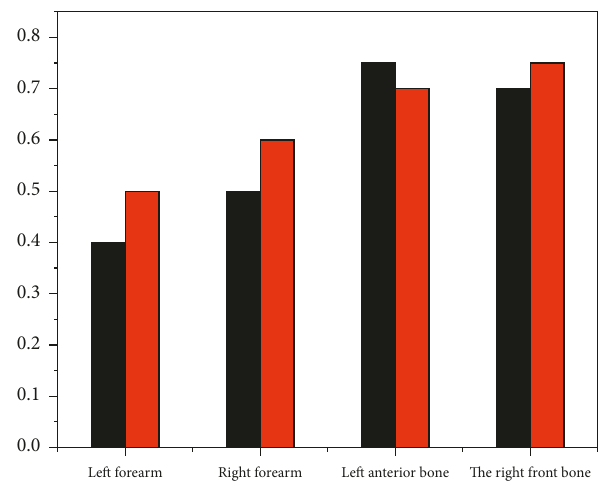
Figure 3: BMD comparison results of female athletes before and after the